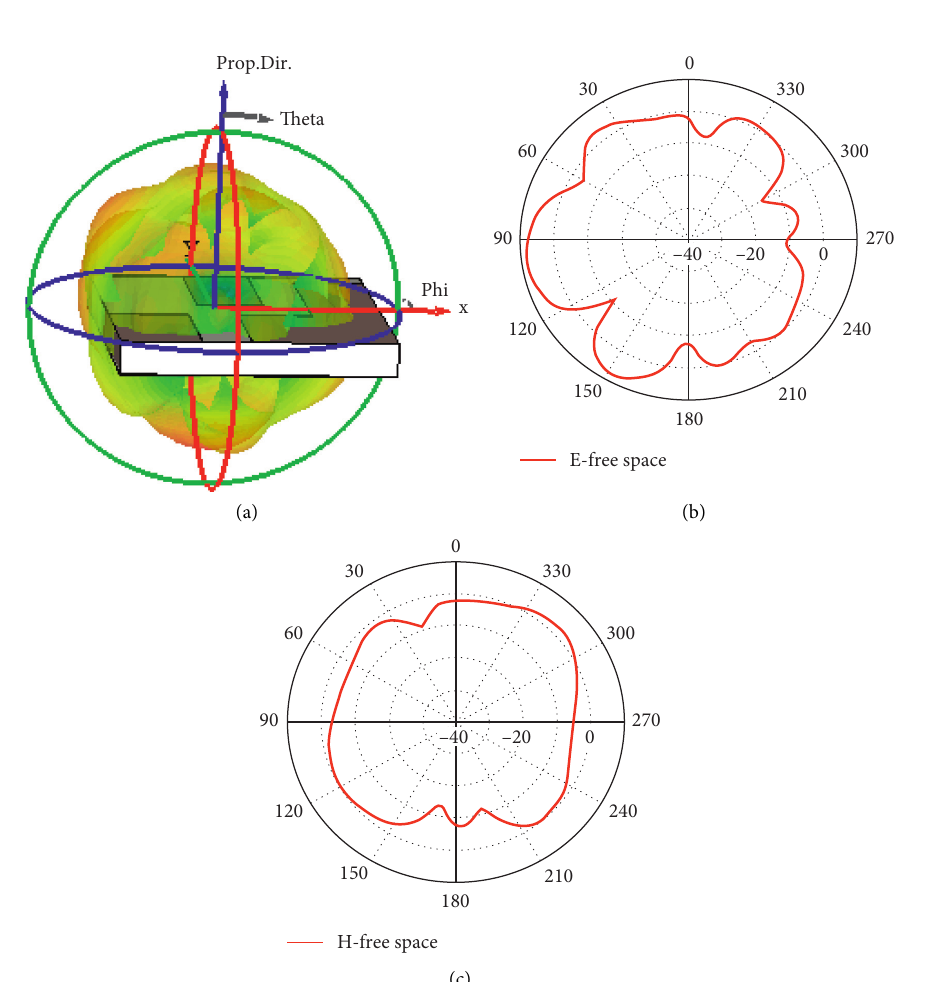
Figure 3: (a) 3D radiation pattern free space for 60GHz, (b) E-plane radiation pattern free space for 60GHz, and (c) H-plane radiation pattern free space for 60